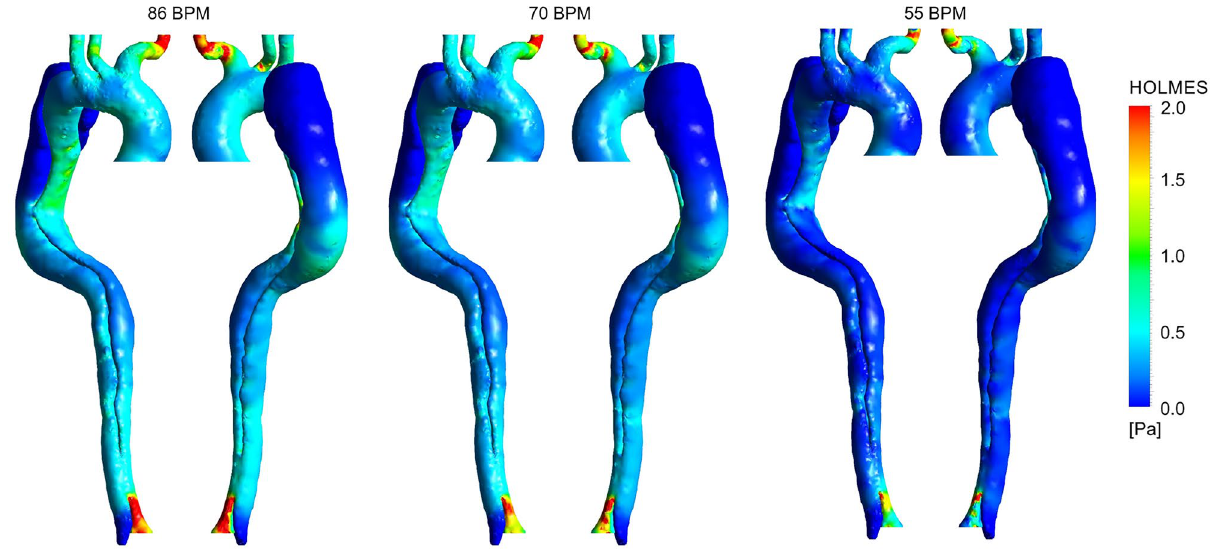
Figure 10. Highly oscillatory, low magnitude shear (HOLMES) distribution for three cases (the scale bar shown in the figure indicates all contours).